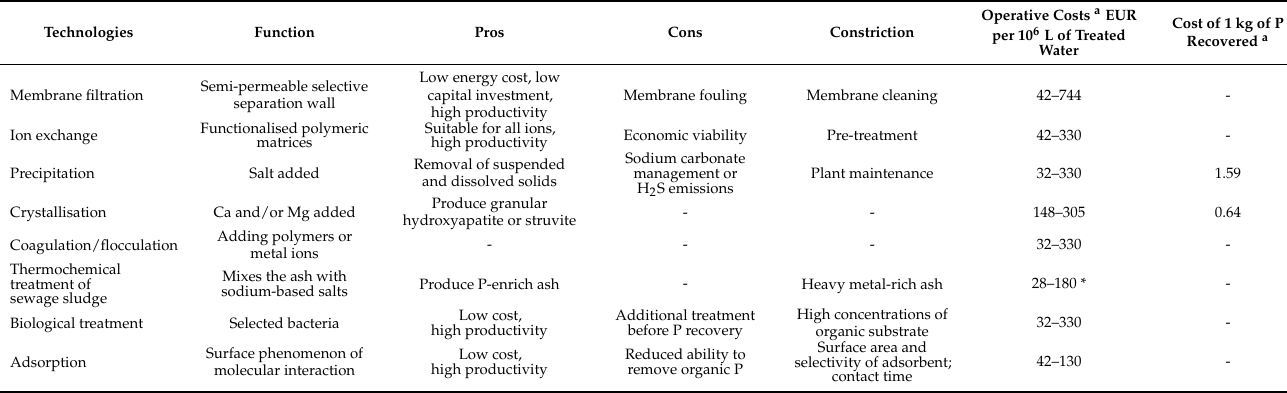
Table 3. Technologies to remove phosphorus from